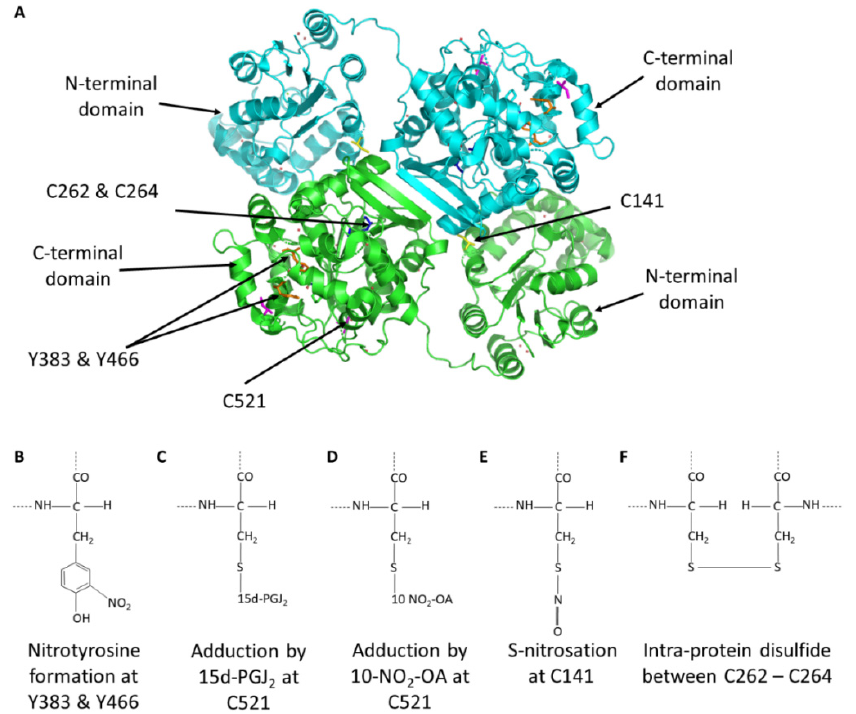
Figure 2. sEH structure ( A ) Domain swapped homo-dimeric structure of sEH. ( B – F ) Overview of various oxidative modifications of sEH and the sites at which they occur.